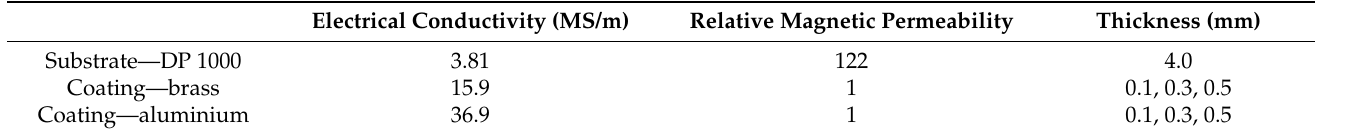
Table 1. Properties of samples.